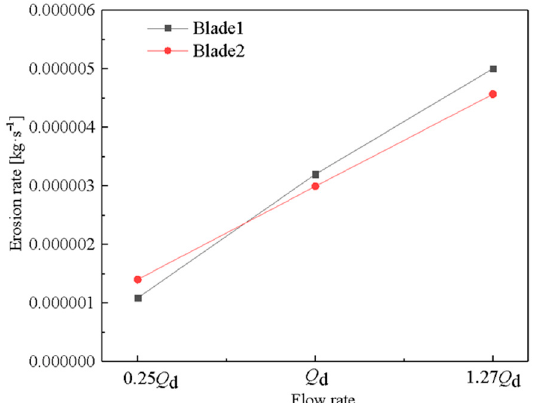
Figure 12. Erosion rate at blade changes with flow rate.